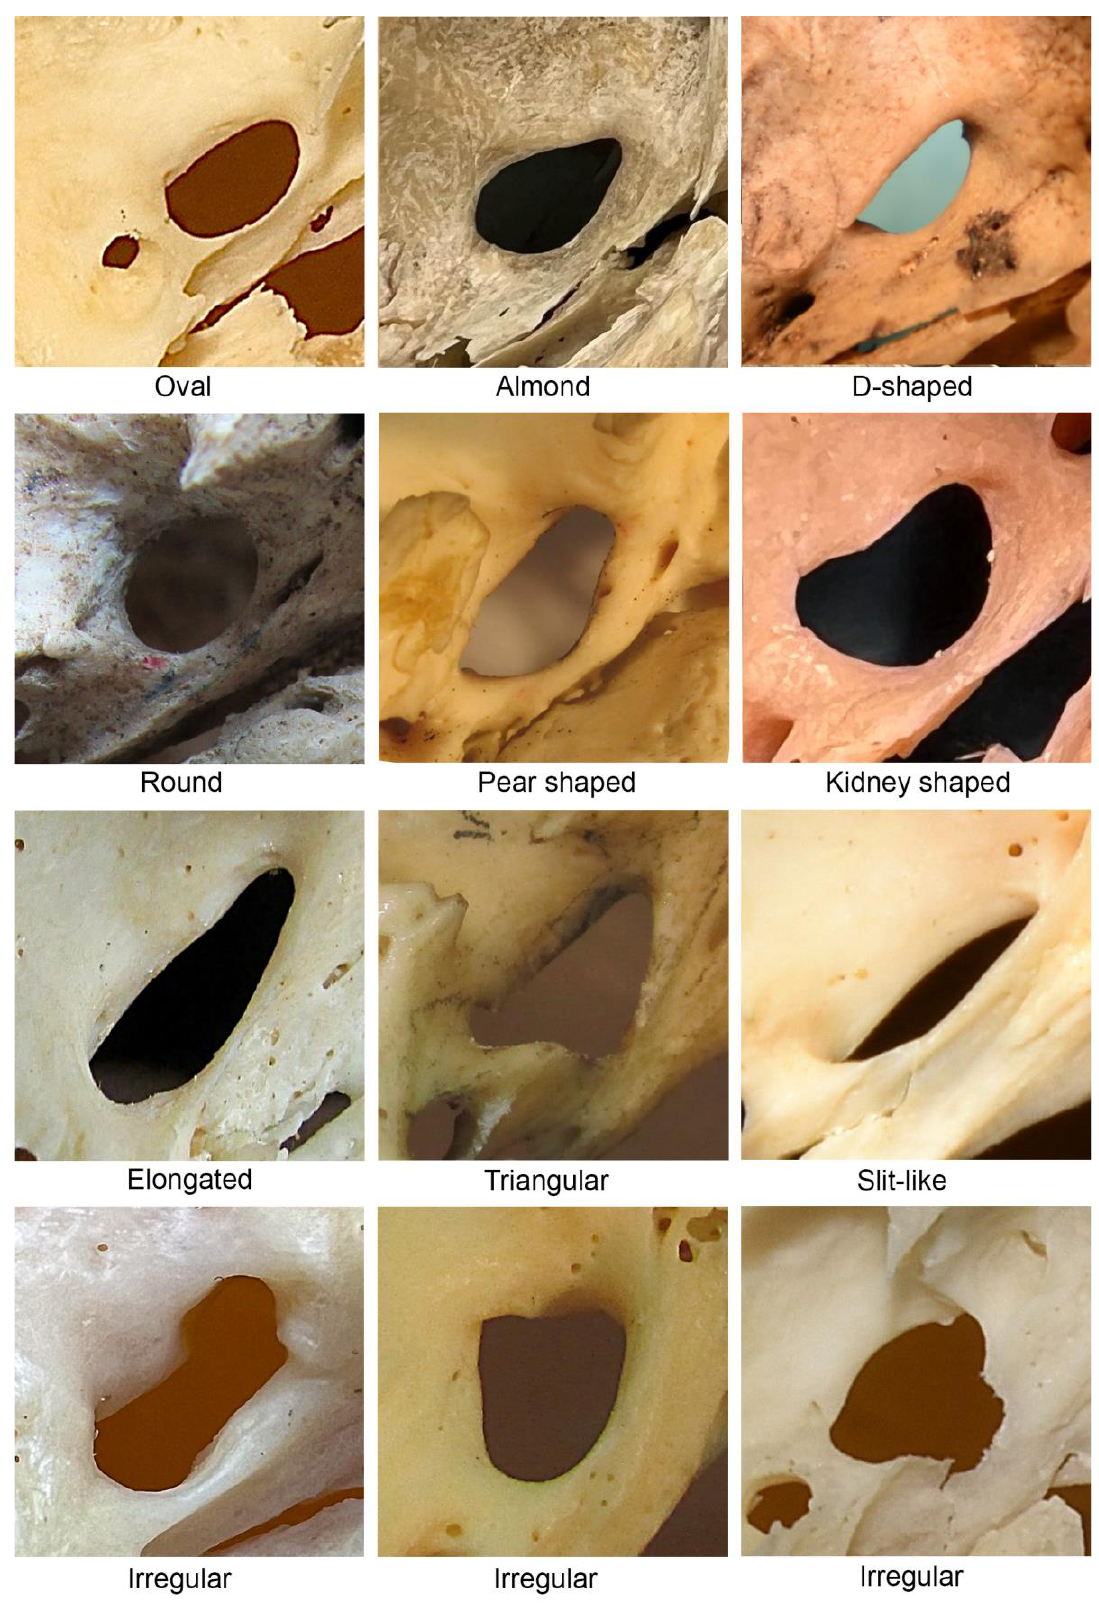
Figure 1. Shapes of the foramen ovale. Images were captured from the external aspect of the cranial base. The upper part of the image corresponds to the anterior, the right part to the medial, the left part to lateral, and the bottom part to the posterior aspect of the cranial base.